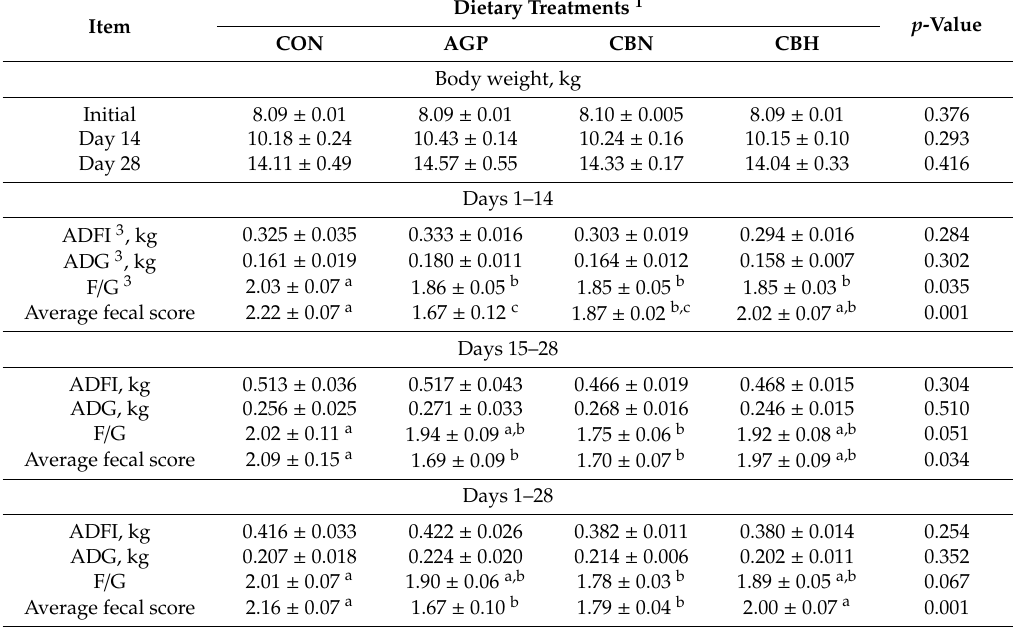
Table 2. E ff ect of dietary C. butyricum on growth performance and average fecal score in weaned piglets (mean ± SE 2 ).